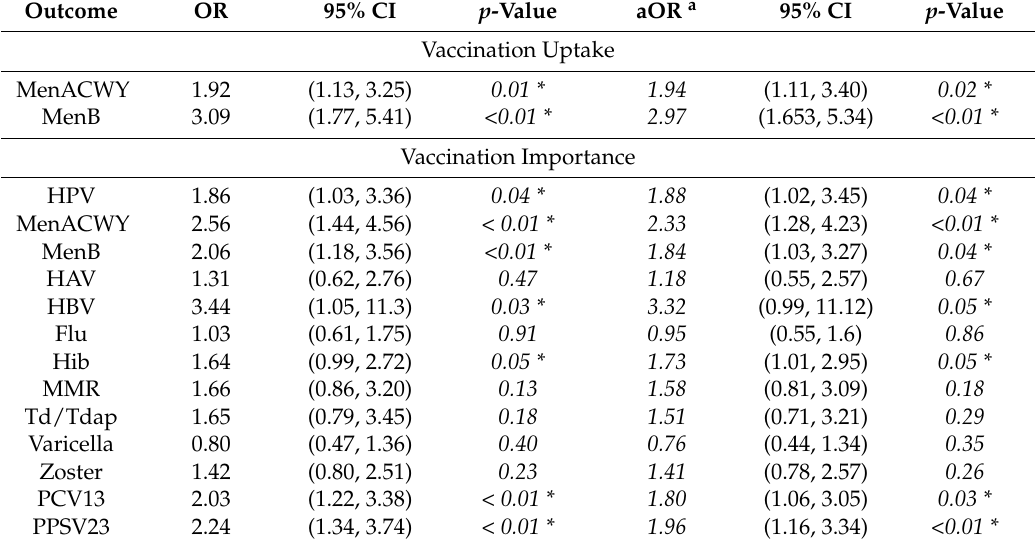
Table 4. Multivariable logistic regression models for opinion leadership membership by vaccine outcome. Outcome OR 95% CI p -Value aOR a 95% CI p